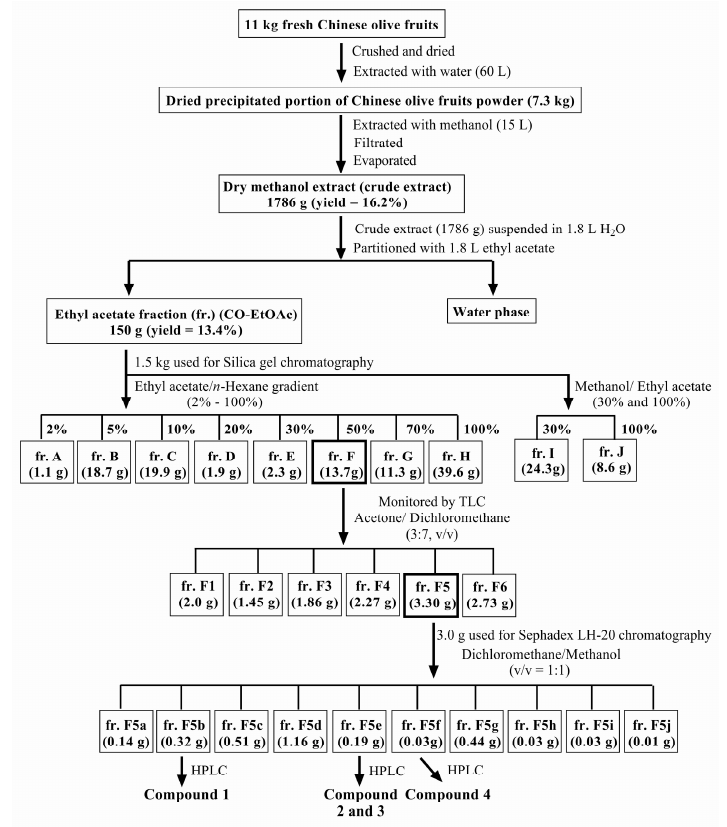
Figure 1. Scheme used to prepare and isolate the anti-inflammatory fractions and compounds in the Chinese olive